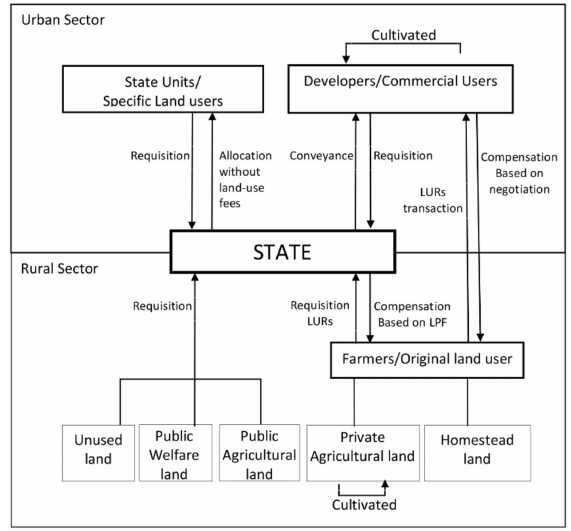
Figure 3. Framework of rural–urban land system in Vietnam (Source: the